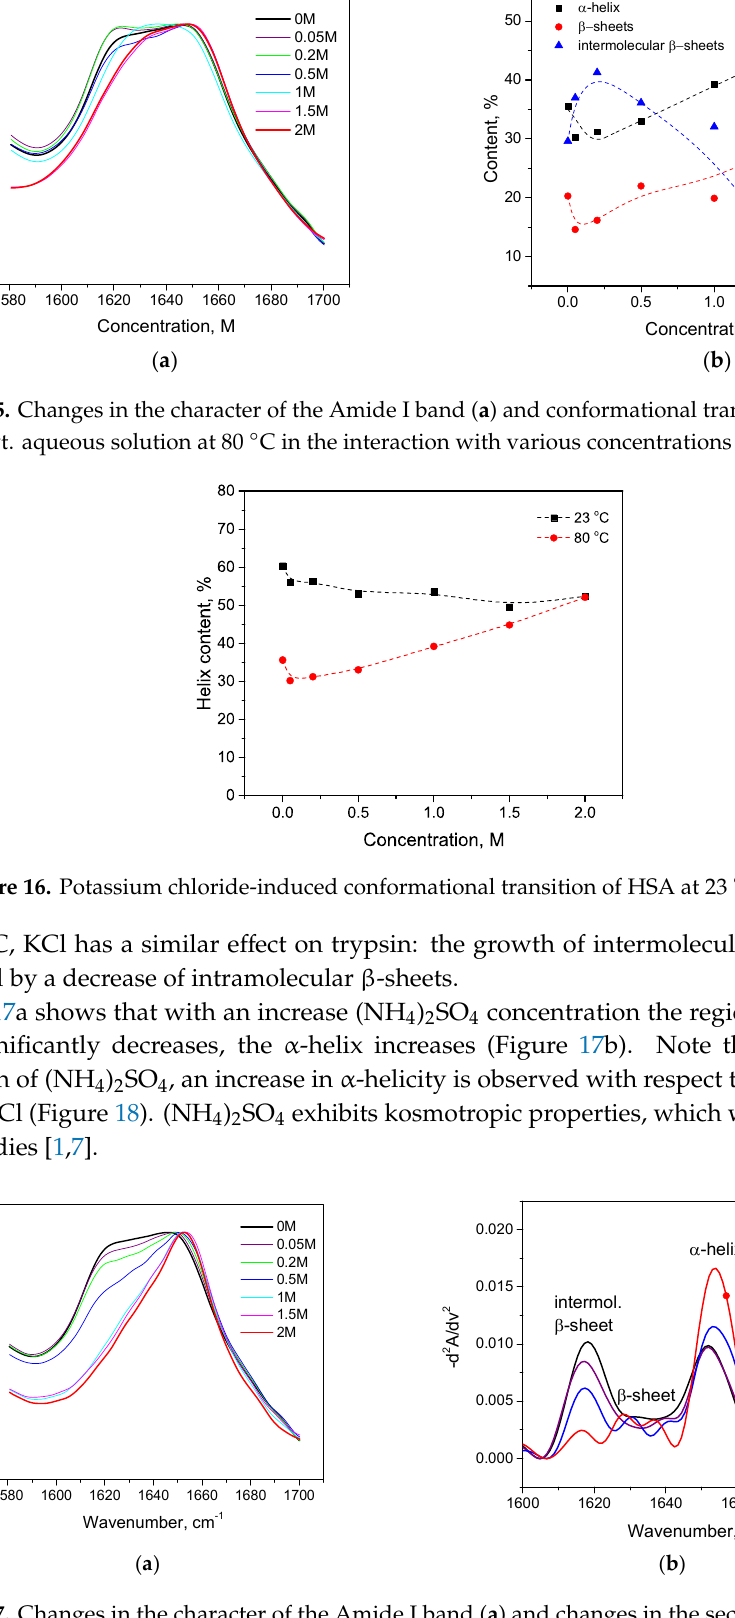
( b ) Figure 18. Changes in the secondary structure of HSA in the interaction with (NH 4 ) 2 SO 4 ( a ) and salt- specific effects on the α-helical secondary structure of HSA( b ) in 10% wt. aqueous solution at 80 °C. After a 10-min exposure at 80 °C in the solution of (NH 4 ) 2 SO 4 , the maximum of the Amide I region shifts by 1622 cm -1 for all concentrations towards the region of intermolecular β-sheets, which become the prevailing elements in the secondary structure of trypsin (Figure 19a). However, this effect was smaller than in the case of KSCN and KCl (Figure 19 b).